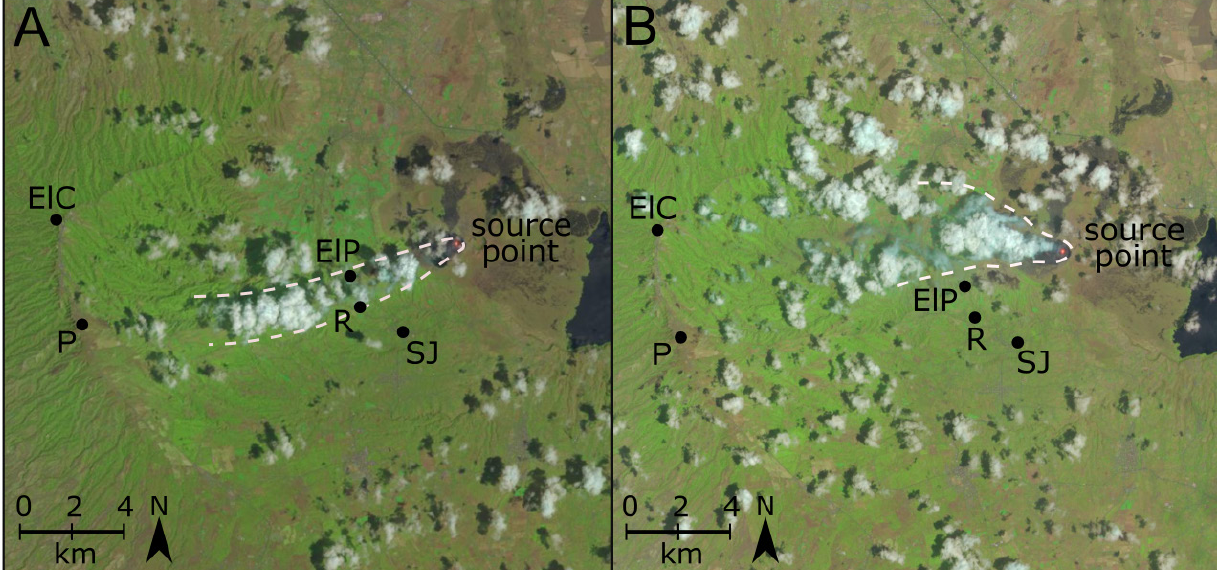
Figure 5: Satellite imagery obtained from the USGS Landlook viewer, annotated with plume trajectories indicated by white dashed lines. The source point (Masaya volcano’s Santiago crater) is visible with the lava lake. AQMesh measurement stations are indicated with black circles and labelled as follows: ElC - El Crucero; P - Pacaya; ElP - El Panama; R - Rigoberto; SJ - San Juan. Plume is visible by semi-linear feature of white condensing clouds initiating from the source point, often interspersed with blue-tinged haze which is likely due to the particulate component. [A] 13 th March 2017 where the plume moves initially towards the south-west before the trajectory alters towards the west. Plume width is approximately 1.5 km. [B] 30 th March 2017 where the plume moves west with a wide lateral spread of approximately 3 km within the first 4 km from the source